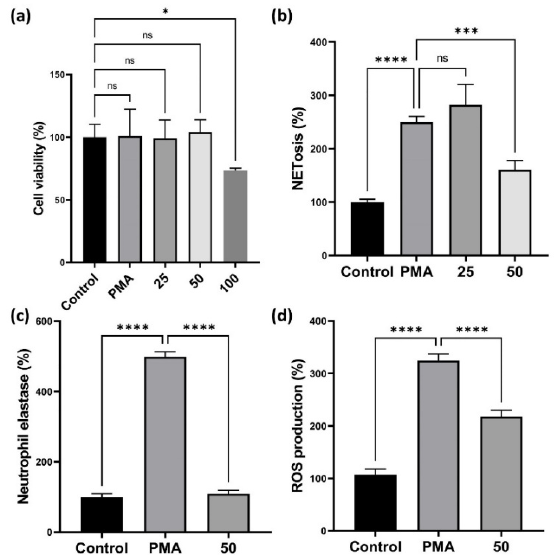
Figure 4. Effect of the CLE on cell viability and the production of NETs, NE, and ROS. ( a – c ) The dHL-60 cells were co-treated with 25, 50, and 100 μ g/mL of CLE and 100 nM PMA for 3h. Then, cell viability, NETs, and NE were analyzed. ( d ) For the detection of ROS production, dHL-60 cells were co-treated with 50 μ g/mL of CLE and 100 nM PMA for 20 min. Data were analyzed by one-way ANOVA by Dunnett’s test. All values are reported as mean SD. * p < 0.05, *** p < 0.001, **** p < 0.0001.